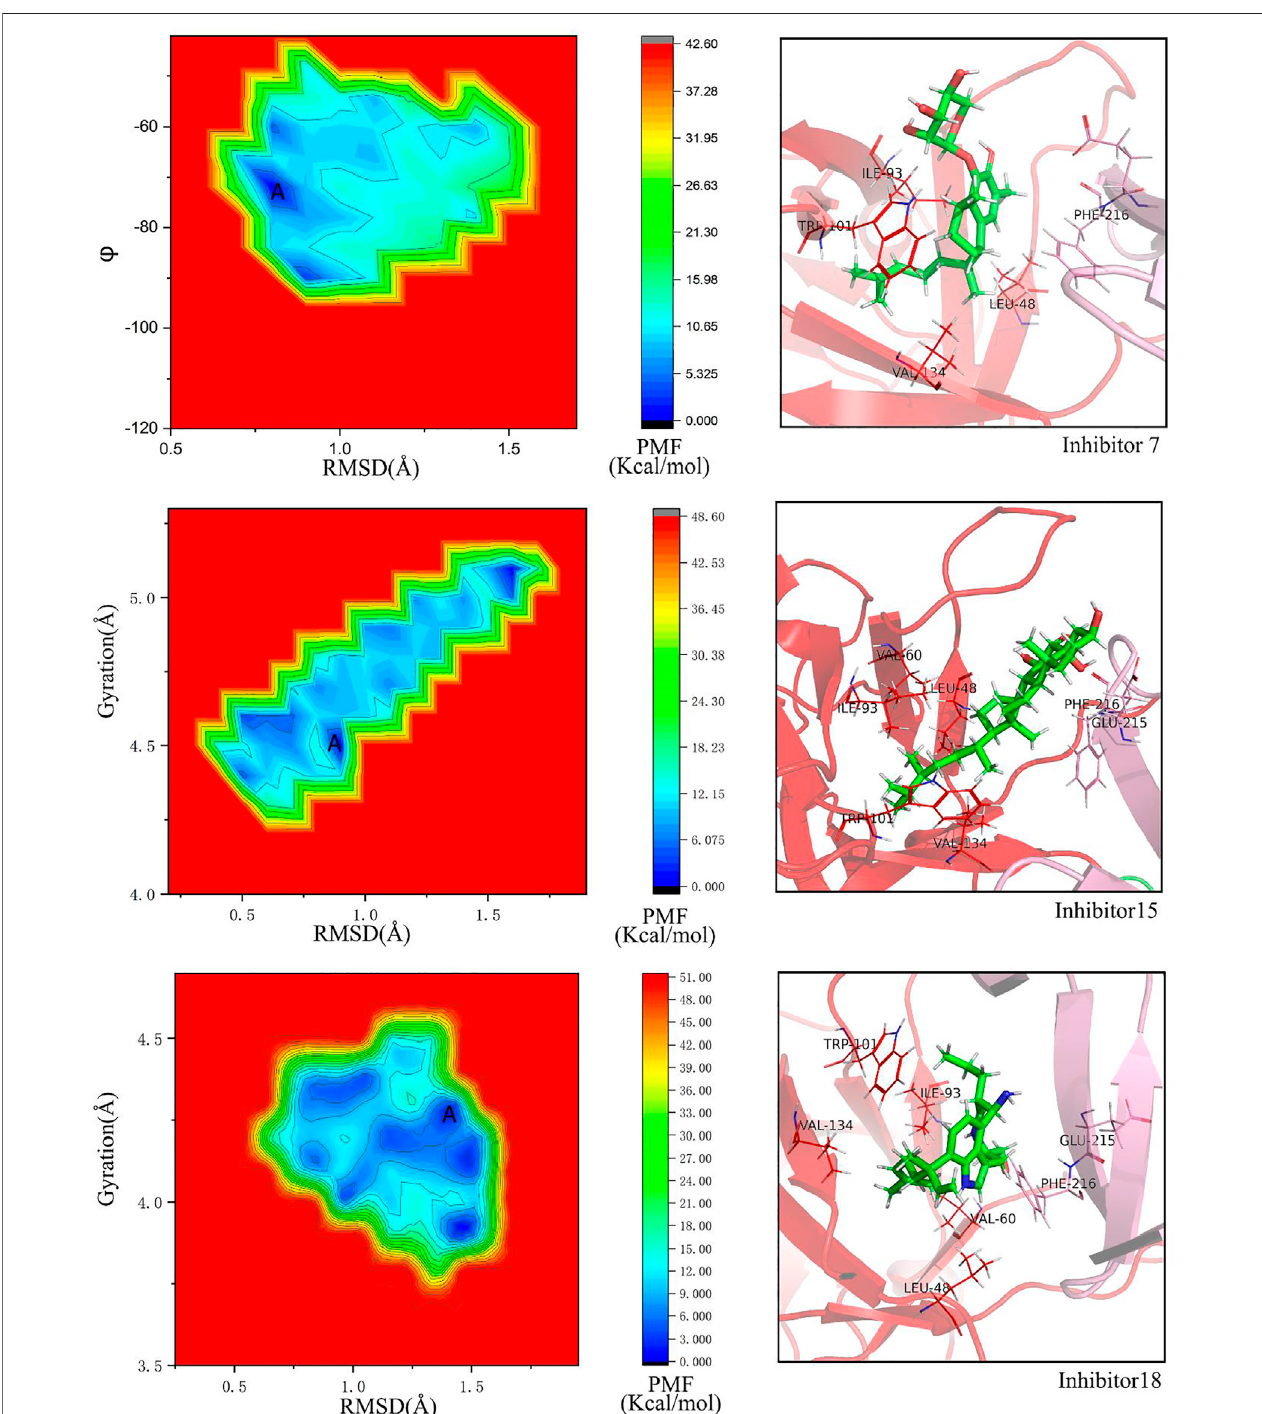
FIGURE8| Freeenergylandscapesandlow-energyconformationalstatesofFascinwithinhibitors,whosewasmodeledwiththeGAFFforce fi eldbyusingLiGaMD simulation: (A) PMFpro fi leofinhibitorNo.07,collectivevariables(CVs)arebackbonedihedrals( φ )andRMSDofinhibitorNo.07. (B) PMFpro fi lesofinhibitorNo.15,CVs are the radius of gyration and RMSD. (C) PMF pro fi les of inhibitor No. 18, CVs are the same with inhibitor No.15.